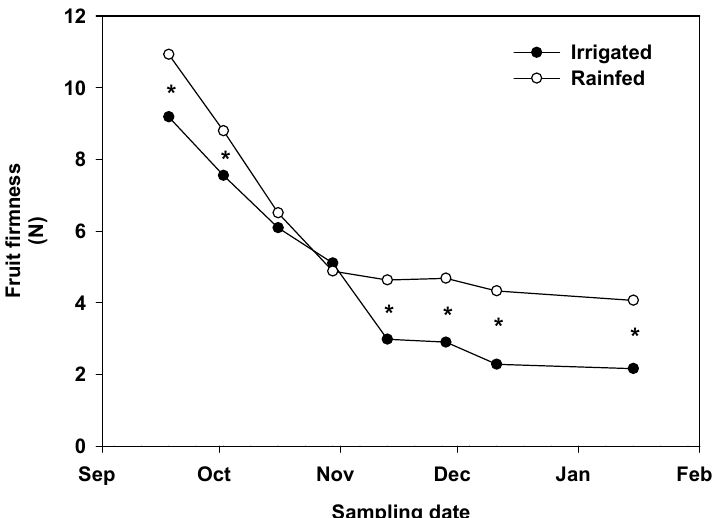
Figure 2. Fruit firmness of ‘Arbequina’ olives during on-tree ripening under irrigated and rain-fed conditions. Values represent means of ten individual fruits. Asterisks stand for significant differences between irrigated and non-irrigated trees at p ≤ 0.05 (LSD test).